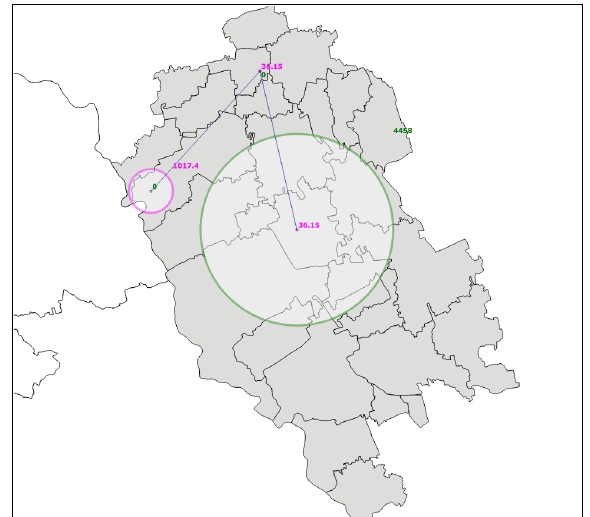
Figure 11. Impact Geography related to a good practice